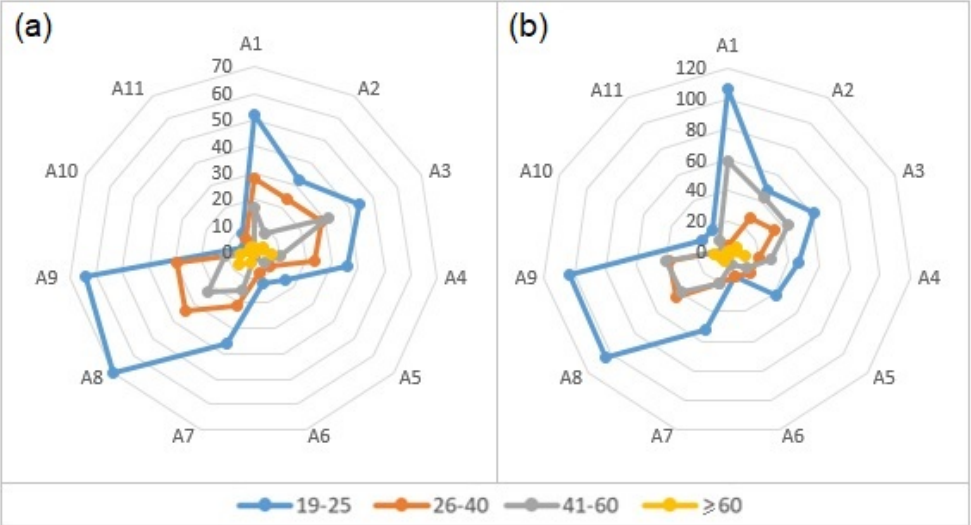
Figure 2. The advantages of the AV concept in the opinion of women ( a ) and men ( b ), A1—convenient solution, A2—efficient use of time, A3—safety, A4—less stress, A5—economy, A6—less congestion on the road, A7—solution for people who do not like driving a car, A8—mobility and A9—independence.